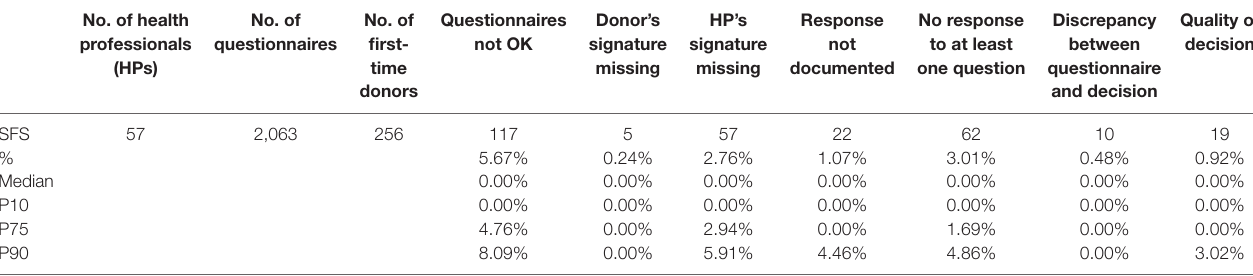
TaBle 2 | Monitoring of donor health questionnaires. no. of health